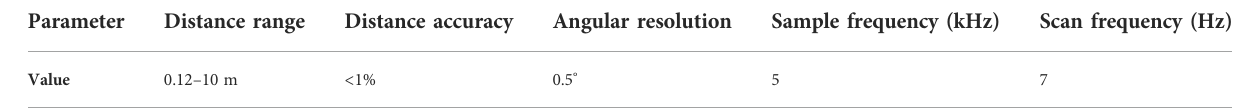
TABLE 1 The speci fi c parameters of YDLIDAR X4.